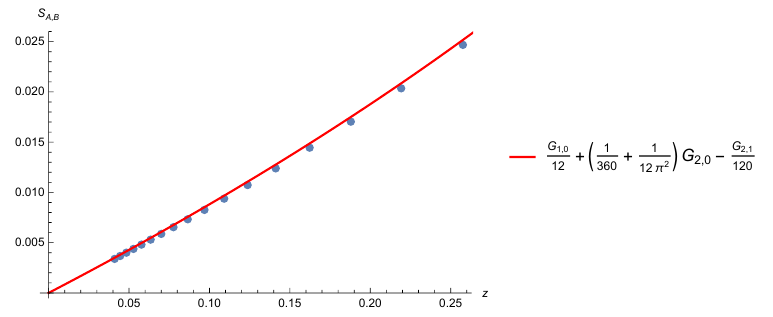
Figure 3 . Mutual information of two disks for 3 d free boson (0 < z < 0 : 25).